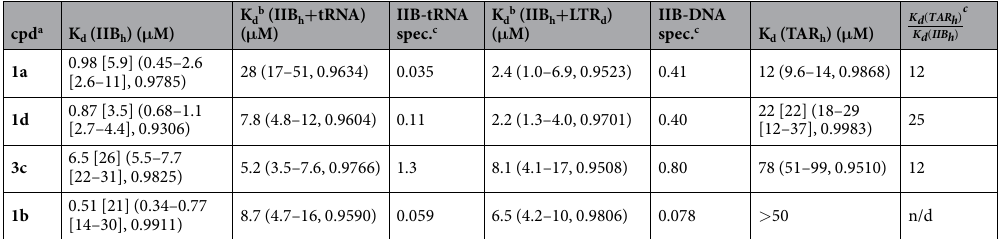
Table 2. IIB h interaction parameters for selected 1,4-terphenyl molecules, measured by fluorescence intensity experiments. a For each compound (cpd), the table report best-fit IIB h and TAR h equilibrium dissociation constants (K d ) obtained in 10 mM sodium phosphate (pH 6.6) and 0.1 mM EDTA. For binding curves best fit with a two-site model, first-site (K d 1) and second-site (K d 2; in brackets) dissociation constants are shown. For IIB h , K d ’s were measured in the absence (IIB h ) and presence of tRNA Lys (IIB h + t RNA) or DNA duplex LTR d (IIB